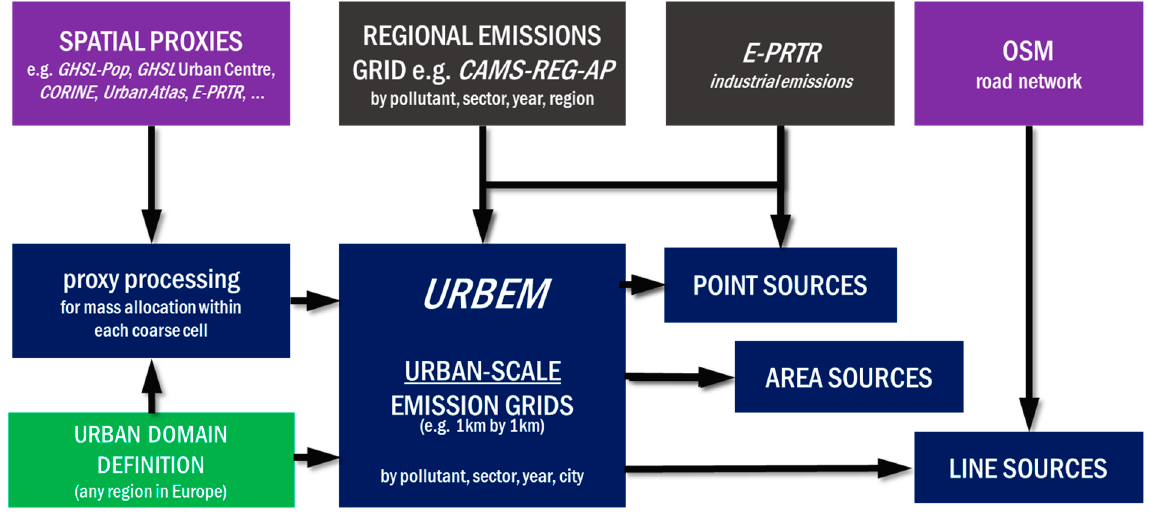
Figure 1. General methodology for the Urban Emissions downscaling framework UrbEm.